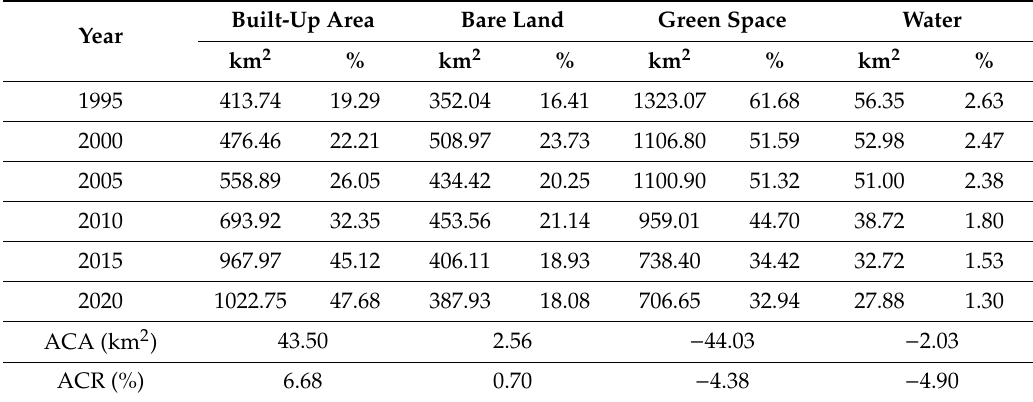
Table 4. Area and changes of each land cover type.